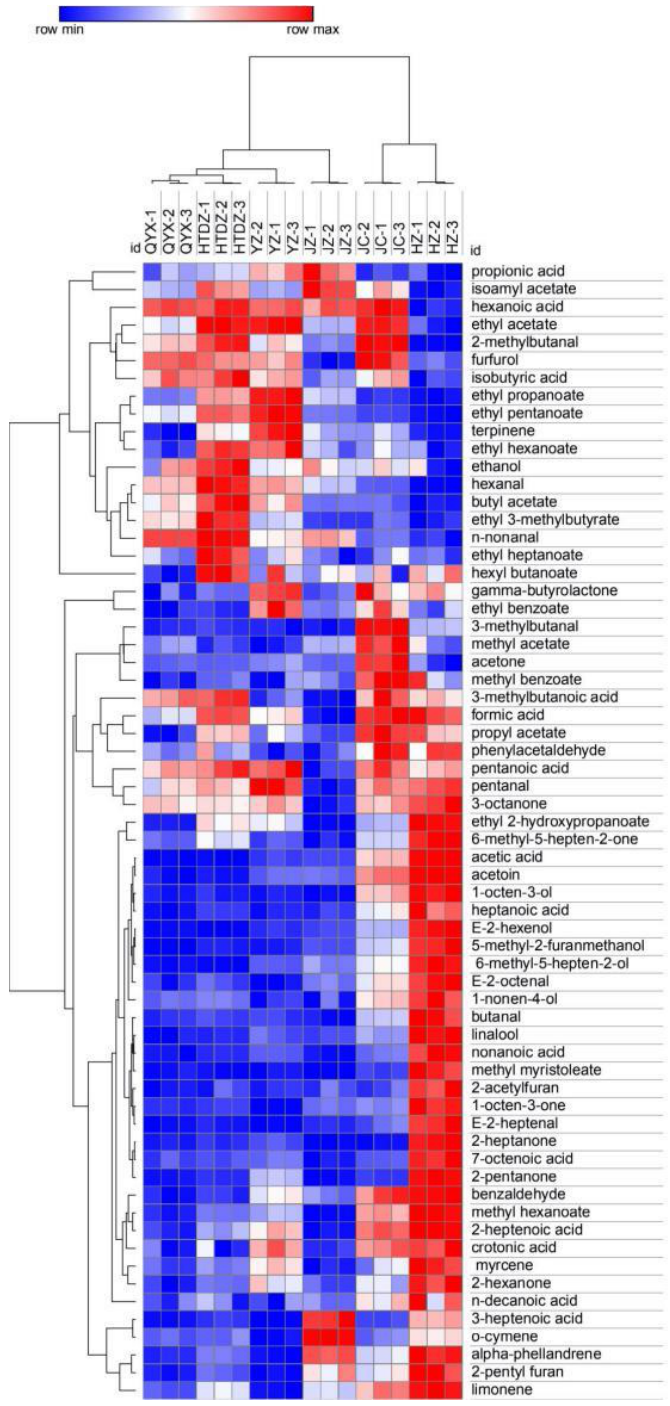
Figure 4. Heatmap analysis of volatiles taken from GC-IMS of the six red jujube culti- vars in Xinjiang Province, China (Jinchang—‘JC’, Junzao—‘JZ’, Huizao—‘HZ’,Qiyuexian—‘QYX’, Hetiandazao—‘HTDZ’, and